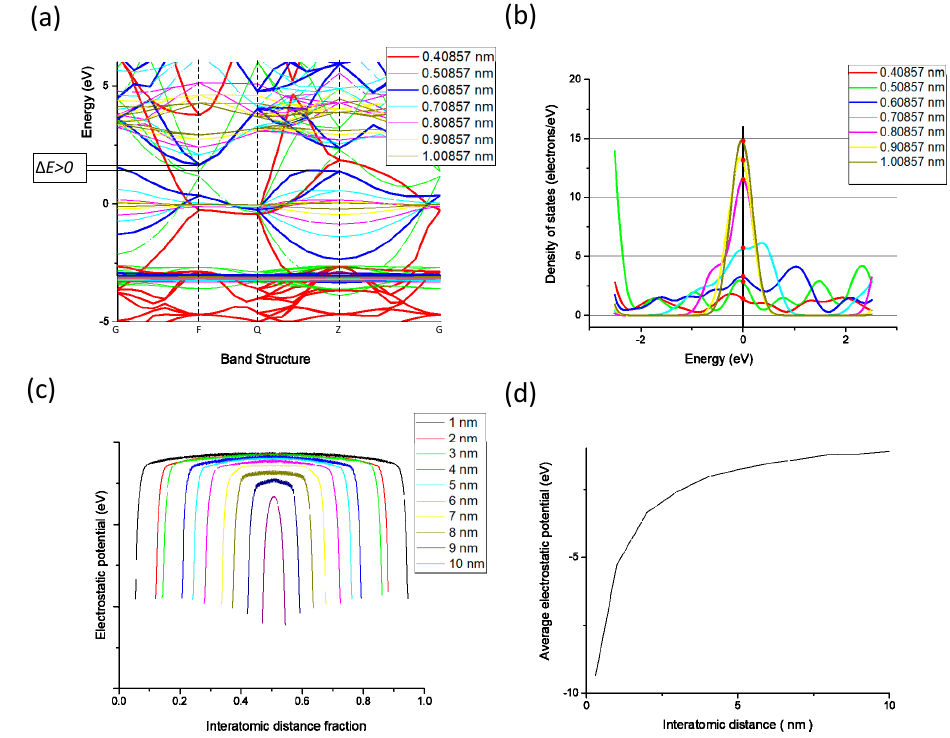
Figure 4. Comparison of ( a ) energy band structures of silver cells with different lattice constants; ( b ) density of states of silver cells with different lattice constants; and ( c ) potential distribution of silver atoms with different spacings; ( d ) average potential of silver atoms at different spacings.